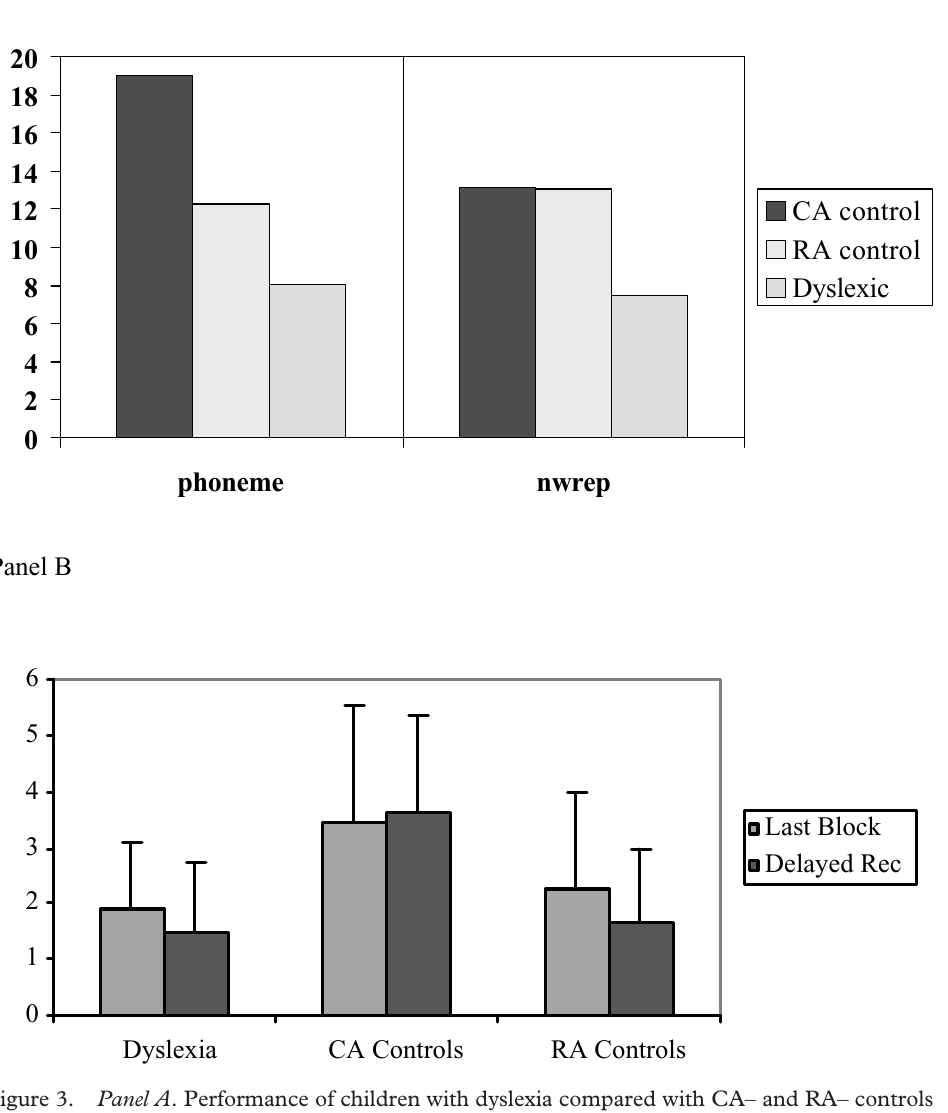
Figure 3. Panel A . Performance of children with dyslexia compared with CA– and RA– controls on tests of phoneme deletion and non-word repetition, showing that the children with dyslexia are impaired (from Marshall et al ., 2001). Panel B. Performance of children with dyslexia on the last block of trials of a letter learning experiment and after a short delay; the children with dyslexia learned fewer letters than age-matched (CA) controls (Goetz,